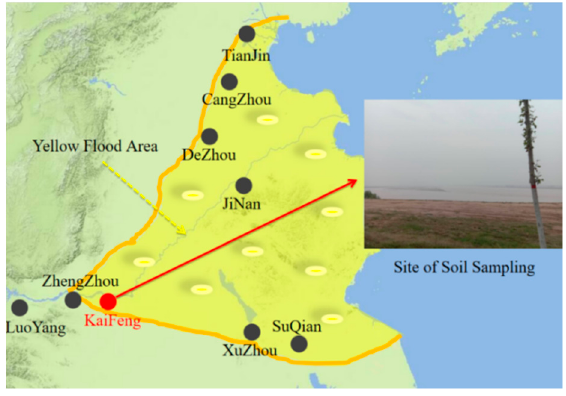
Figure 1. Site of soil